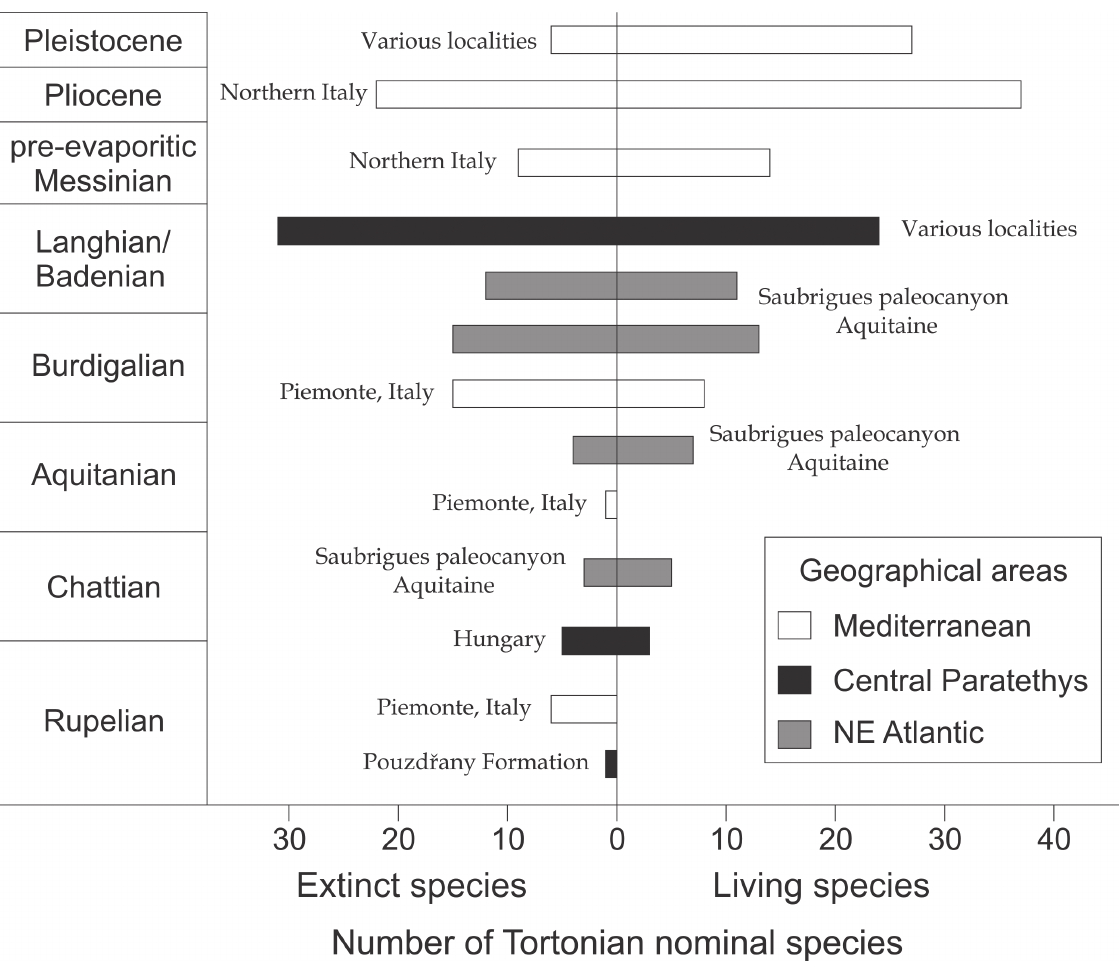
Fig. 13. Placement of the Tortonian otolith-based fauna in time and space. Number of the Tortonian nominal species shared by various otolith assemblages is indicated separately in extinct and living species. Note that the investigated otolith assemblages within each geological time interval (Series / Stage) are not placed